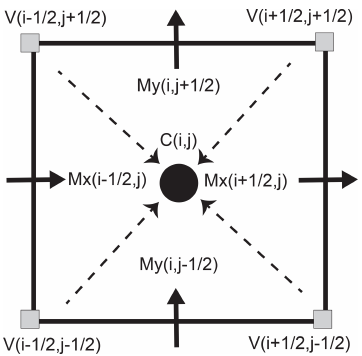
Figure 1. Setup of the staggered grid in 2-D. Variable C is located at the cell centre, V depicts variables located at cell vertices, and M x and M y represent variables located at cell mid-faces in the x or y